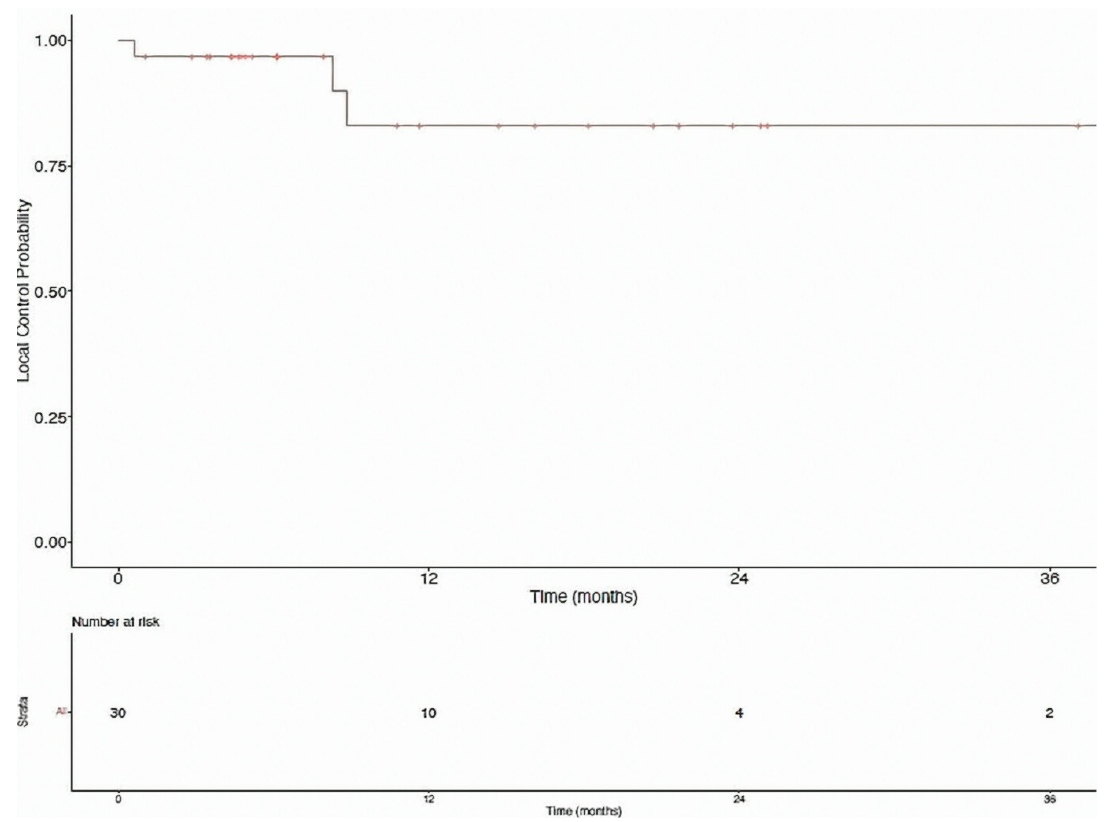
Figure 4. Local control of oligoprogressive sites treated with radiation therapy. Hematological parameters, including the absolute neutrophil count (ANC) and the neutrophil-to-lymphocyte ratio (NLR), were available for 29/30 patients. The mean